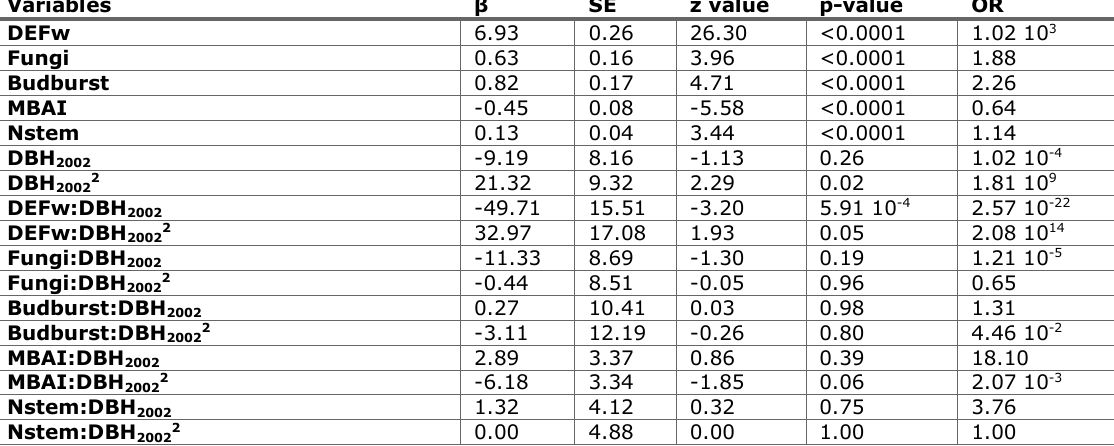
Table 2. Effects of tree characteristics on the individual tree’s probability of mortality . Variables are defined in Table 1. Effects were estimated with a logistic regression model (equation 8 ). β is the maximum likelihood estimate, with its estimated error (SE), z-value, and associated p-value. OR is the odds ratio.